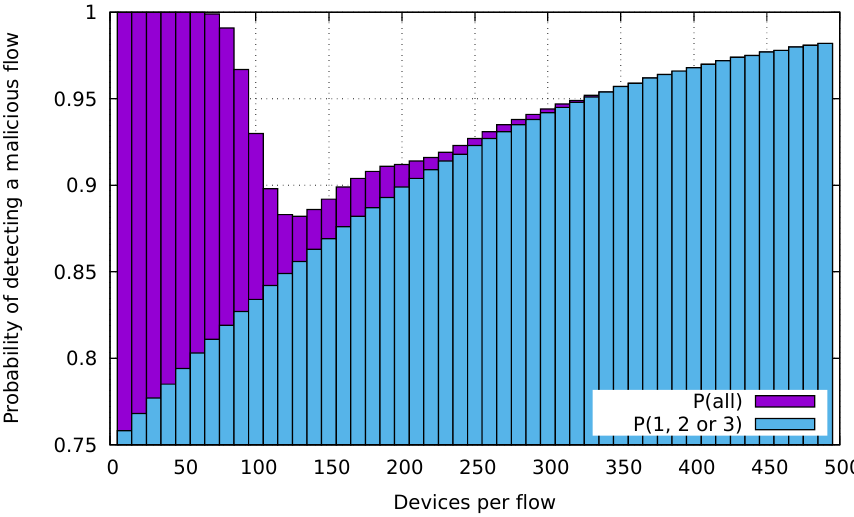
Figure 3. Probability of detecting a flow which contains malicious devices (given by Equation (A1)) and the contribution of flows which contain malicious devices of type different than manufacturing cell (given by Equation (A2)) for s p = 1s, t r = 1.01, f m = 100 and p m = 0.01